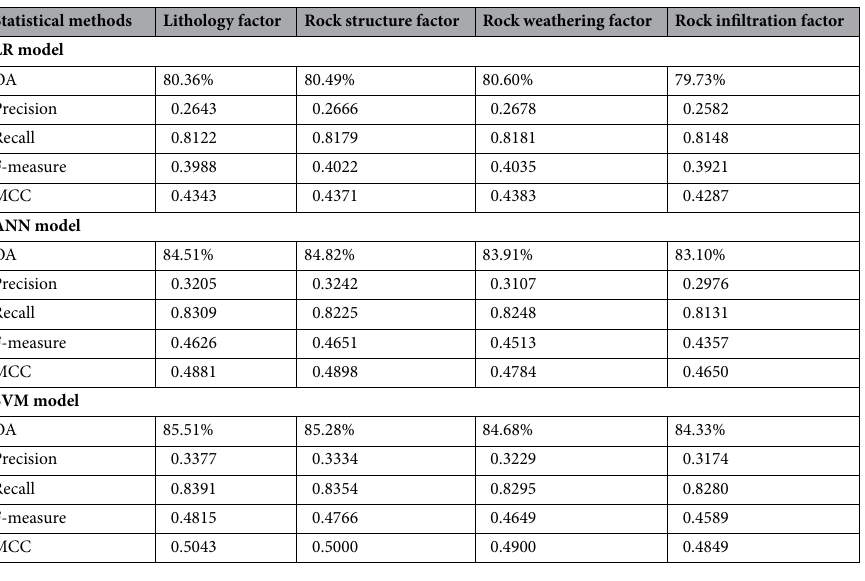
Table 9. The results of five statistical